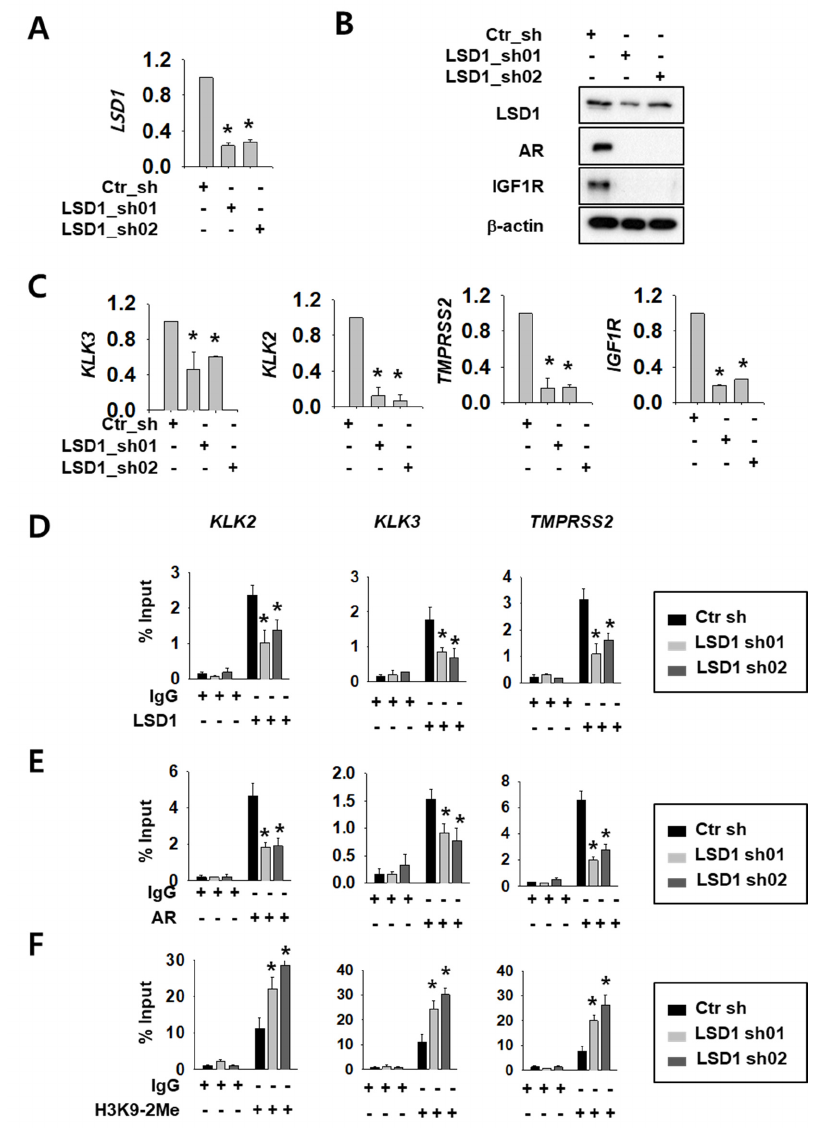
Figure 1. Lysine ‐ specific histone demethylase 1 (LSD1) knock ‐ down reduces androgen receptor